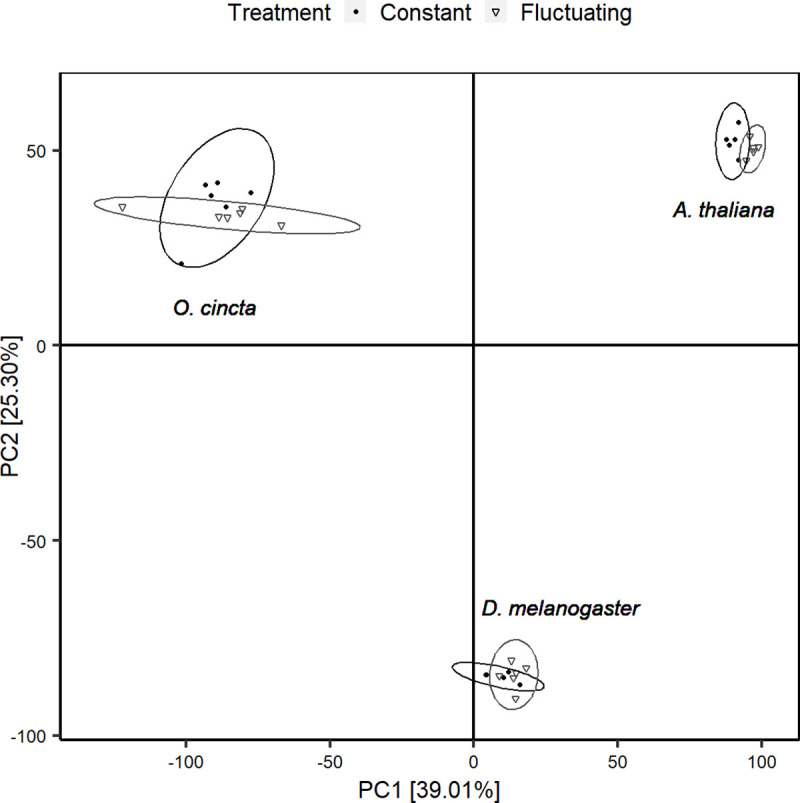
PCA scores plot.PCA on metabolite spectra from whole-body extract of D. melanogaster, O. cincta, and A. thaliana acclimated to constant (filled circles) and fluctuating (open triangles) thermal regimes. PC1 and PC2 account for 39.01% and 25.39% of the variance between samples, respectively.